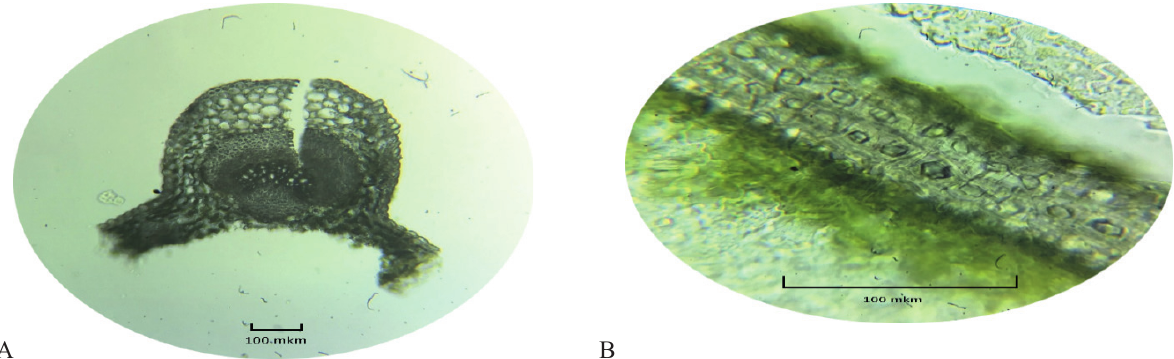
Figure 3. T. pratense leaf central vein (cross section, A ); crystal vein leaf coating ( B